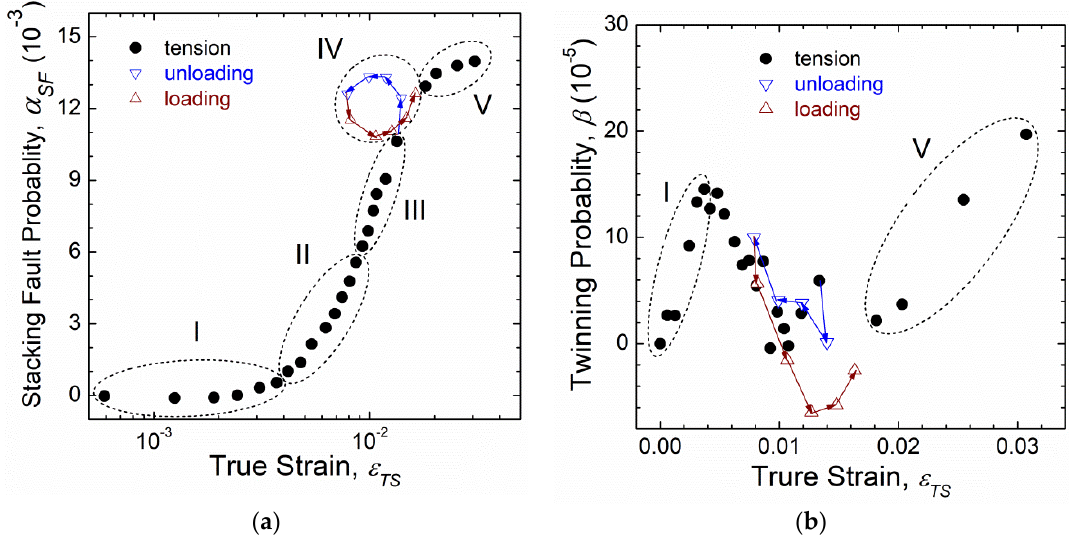
Figure 8. ( a ) Stacking fault probability α SF and ( b ) twinning probability β vs. true strain ε TS for nc-Ag in tension and during unloading-loading. Arrows: the sequences of unloading-loading. Dashed ovals: the five deformation regimes (I to V).